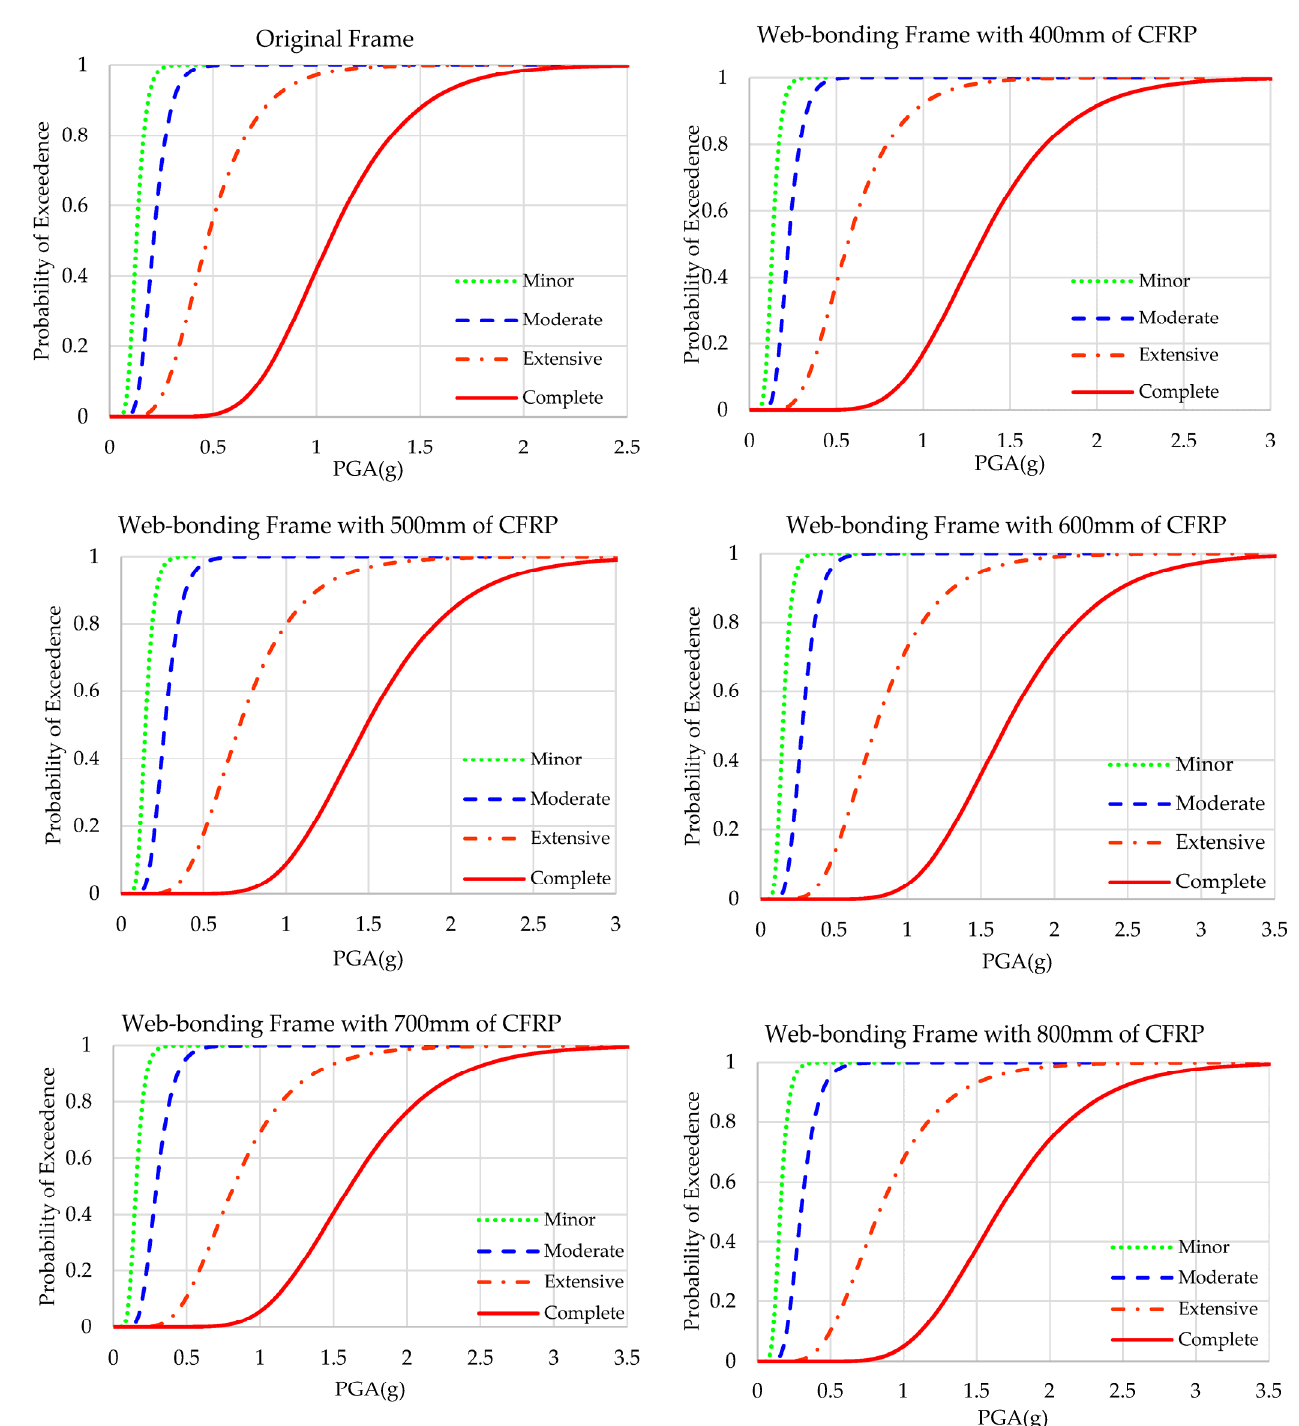
Figure 9. Fragility curves of the original and CFRP web ‐ bonding frames.